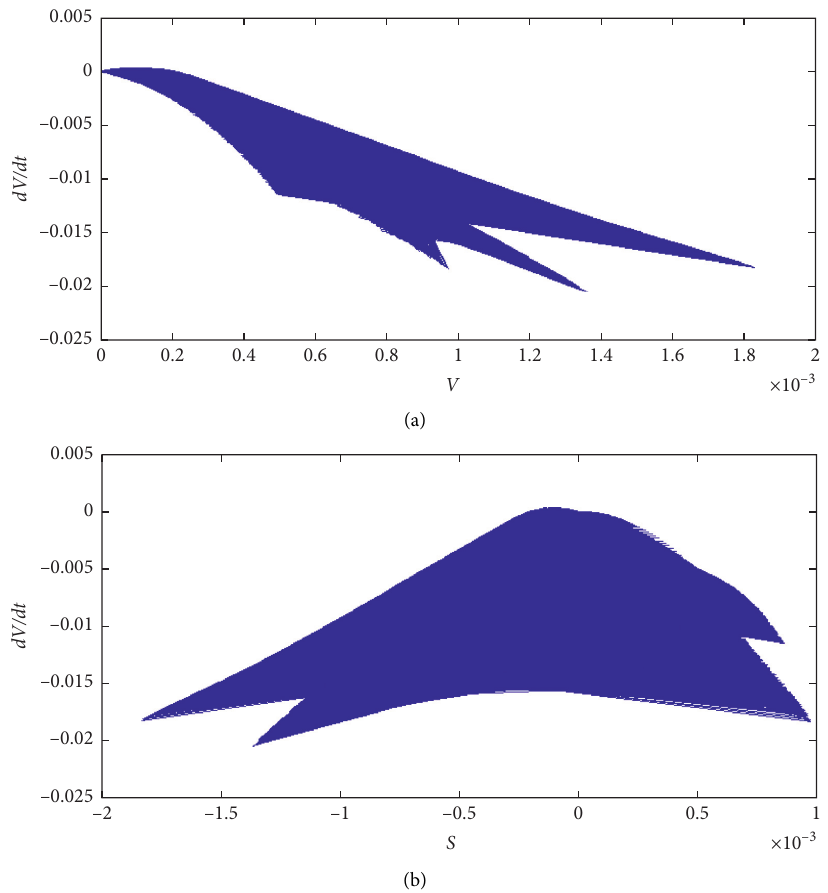
Figure 22: d V /d t versus V and s for the controlled system with σ � 0 . 0005. (a) d V /d t versus V and (b) d V /d t versus s